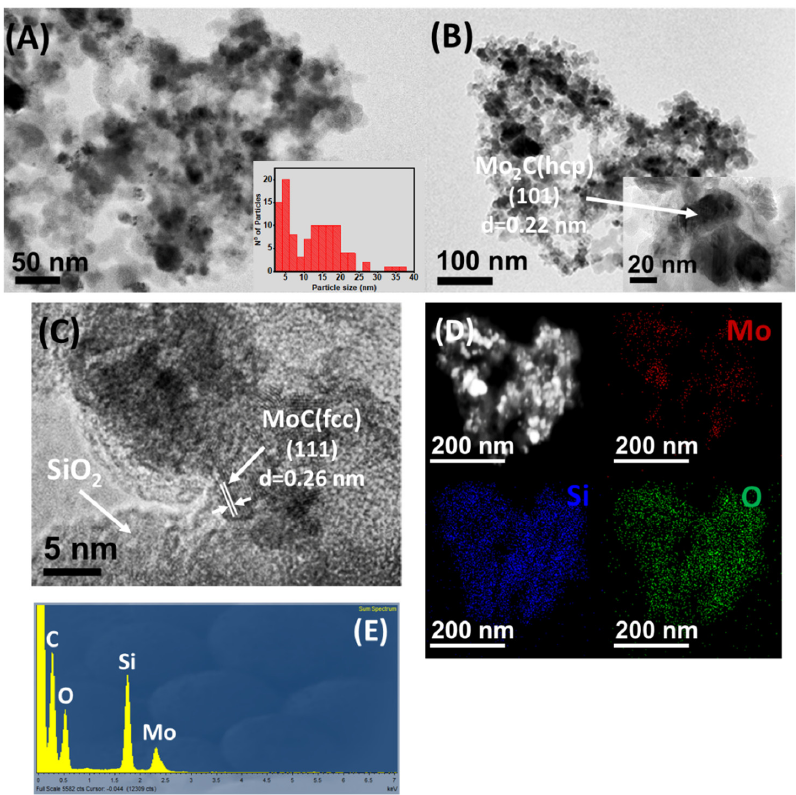
Figure 5. ( A – C ) TEM − HRTEM micrographs of Mo x C/SiO 2 catalyst; ( D ) STEM − EDX mapping; ( E ) EDX spectrum.